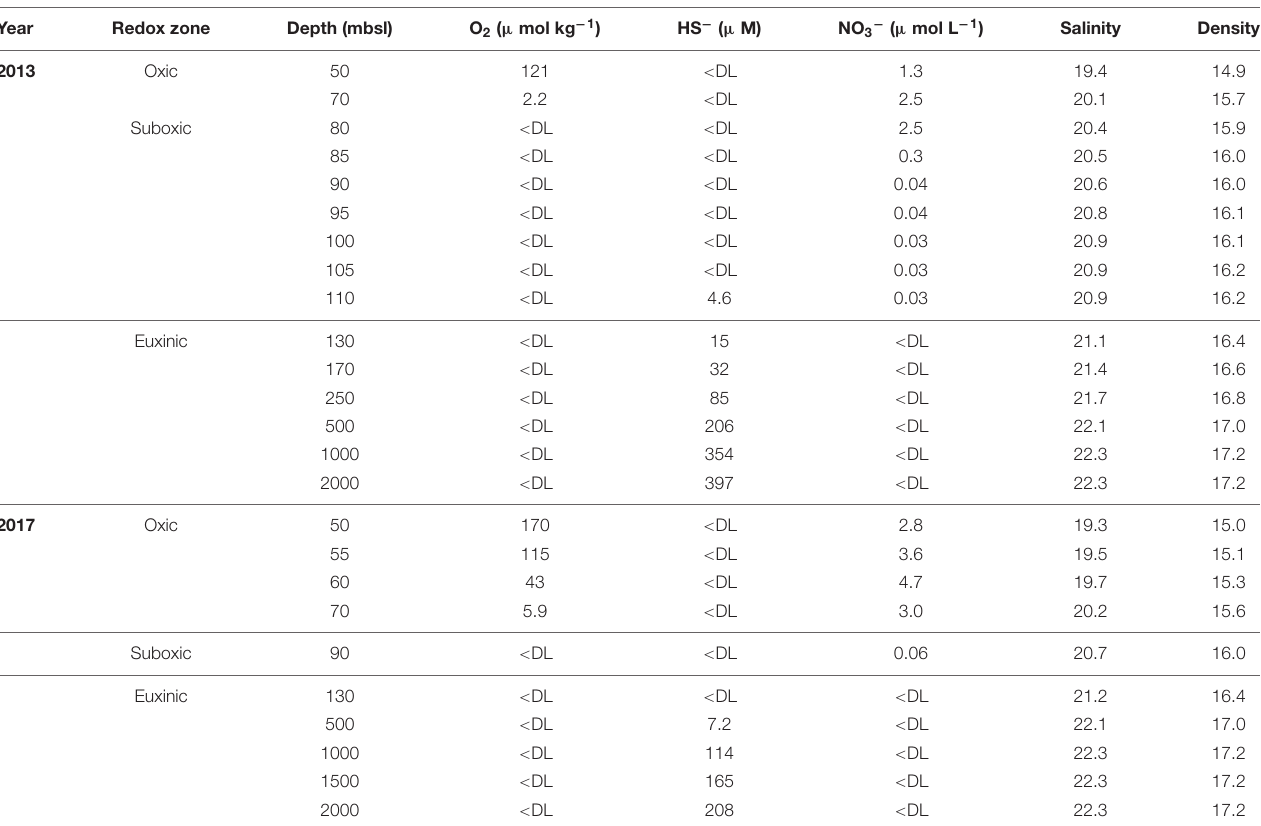
TABLE 1 | Depth of SPM sampling and hydrological properties in the water column in the center of the western gyre of the Black Sea at sampling station PHOX2 in March 2013 and station 64PE418-4 in June 2017. Year Redox